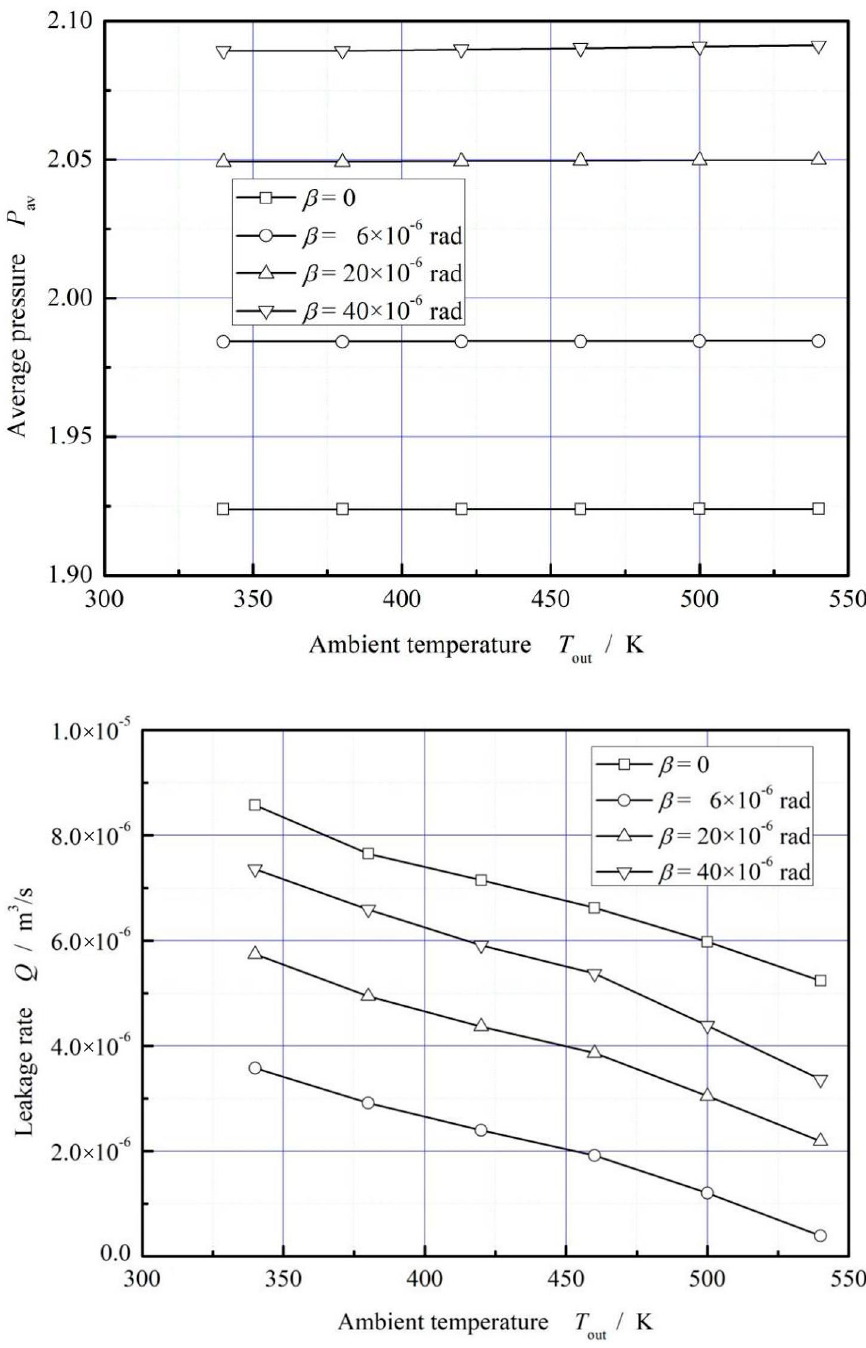
Figure 16. Influence of ambient temperature on dimensionless mean pressure and leakage. ( p i = 0.2 MPa, ω = 3.0 × 10 4 r/min, T in = 580 K).